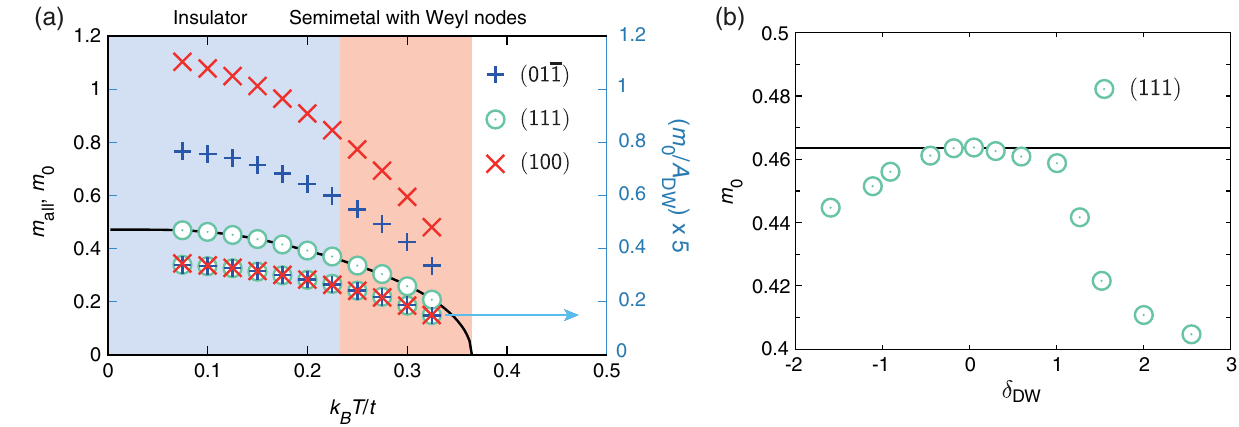
FIG. 7. Uniform magnetization m 0 induced around the domain walls. (a) Uniform magnetization m 0 induced around the domain walls per supercell shown as the top three symbols at each temperature for three different domain-wall planes, in comparison with the bulk all- in – all-out magnetic ordered moment m (solid black curve). The uniform magnetization per unit area ( a 2 ) of the domain walls m 0 =A all is also shown as the three lowest symbols at each temperature. Here, the area of the intersection of a supercell with the domain walls A ffiffiffi ffiffiffi p p 01¯1 2 3 for the ( ), (111), and (100) domain walls are 8 , 4 , and 16 in units of a 2 , respectively. These three data points are almost on top of each other. (b) Doping dependence of the uniform magnetization of the (111) domain wall for k defined as an increase or decrease of the electron number per present supercell around the domain walls due to changes in the chemical potential. It shows that the uniform magnetization is insensitive to the charge doping around the domain wall, within j δ more than one electron is doped in the supercell around the domain wall, the reduction of the uniform magnetization becomes significant, with an asymmetry between electron and hole